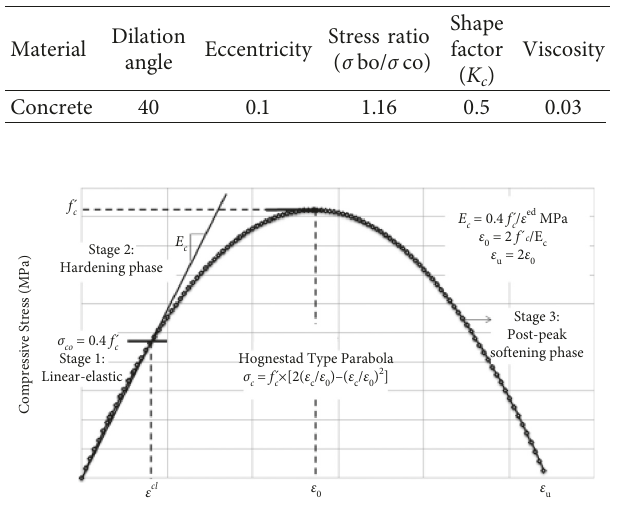
Figure 6: Hognestad pre- and post-peak parabolic concrete compression response [26].